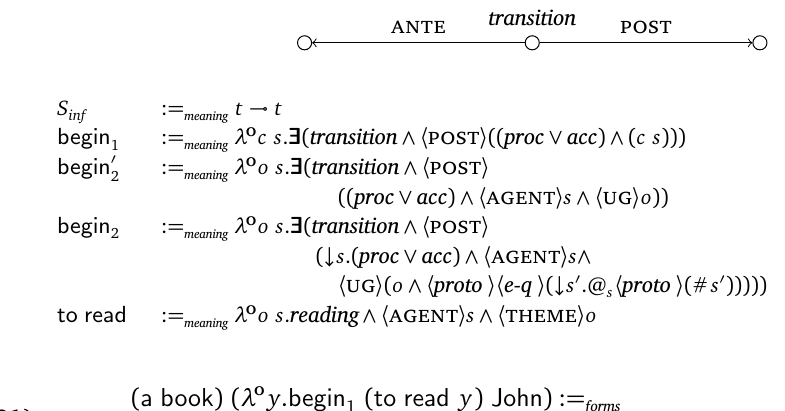
transition ante post